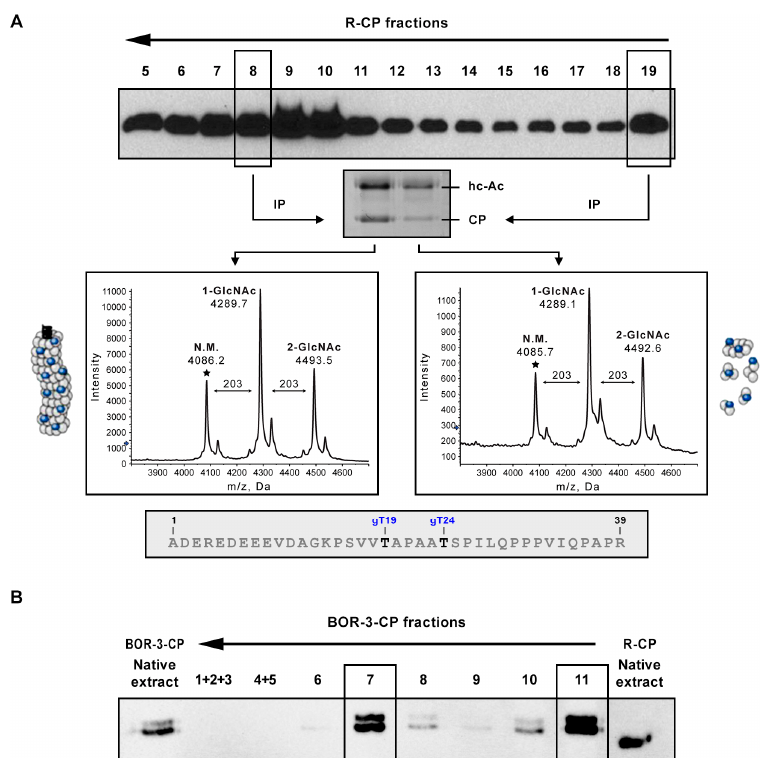
Figure 1. Analysis of post-translational modifications a ff ecting the coat protein (CP) of the Plum pox virus (PPV) when assembled or unassembled in viral particles. Upper non-inoculated leaves of Nicotiana benthamiana plants infected with PPV-R (strain D) ( A ) or PPV-BOR-3 (strain Rec) ( B ) were collected at 17 days post-inoculation. Crude extracts from plant tissue were prepared under native conditions and subjected to sucrose gradient centrifugation. ( A ) Western blot anti-CP of sucrose gradient fractions from PPV-R-infected plants. Fractions containing small complexes and free CP (19) or viral particles (8) were separately immunoprecipitated (IP) with anti-CP serum. CP recovery following IP was checked by SDS-PAGE and Coomassie blue staining. Immunoprecipitated CP and immunoglobulin heavy chain are indicated. O -GlcNAcylation of the CP of PPV-R (R-CP) from each immunoprecipitated fraction was analyzed by matrix-assisted laser desorption / ionization-time flight. Spectra corresponding to peptide 1–39 are displayed. Mass / charge ratios ( m / z ) assigned to relevant peaks, as well as predicted number of O -GlcNAc residues modifying each peptide species, are shown. Stars mark unmodified parental (N.M.) peaks. The sequence of peptide 1–39 and their O -GlcNAcylated residues are shown below spectra. ( B ) Western blot anti-CP of sucrose gradient fractions from PPV-BOR-3-infected plants. Fractions containing small complexes and free CP (11) or virus-like particles (7) are boxed. The double band of the CP of PPV-BOR-3 (BOR-3-CP) indicates its partial phosphorylation. Non-fractioned extract (native extract) of PPV-BOR-3 and PPV-R, whose CP migrates as a single band, are also shown. Both in ( A ) and ( B ), the arrow on top of Western blots indicates the sedimentation sense.